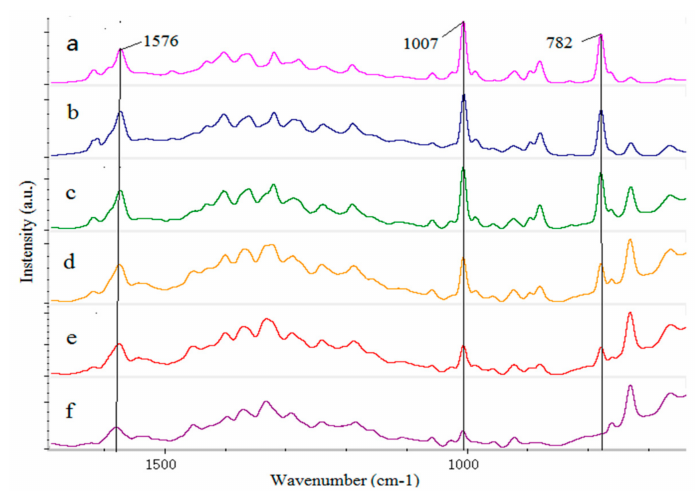
Figure 5. The SERS of thiabendazole pesticide solution in rape: ( a ) 10 mg/L; ( b ) 5 mg/L; ( c ) 1 mg/L; ( d ) 0.5 mg/L; ( e ) 0.1 mg/L; ( f ) 0.05 mg/L.